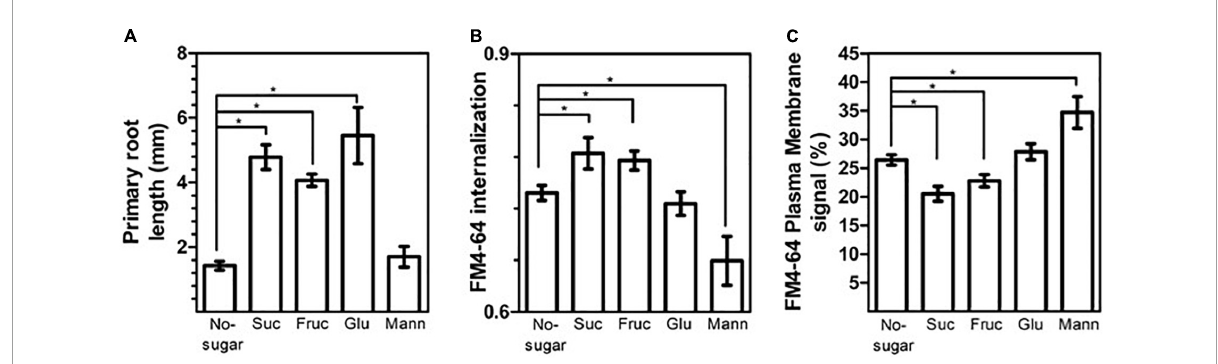
FIGURE7 The sucrose monosaccharide fructose mimics the effect of sucrose on cell elongation and endocytosis. Wild-type Arabidopsis (Col-0) seeds were sown on sugar-free solid medium (No-sugar) and solid medium supplemented with 60 mM sucrose (Suc), fructose (Fruc), glucose (Glu) or mannitol (Mann). (A) Primary root length of seedlings was scored after 7 days from three independent biological replicates of n ≥ 20 seedlings for each condition. (B,C) Endocytosis was evaluated in root epidermal cells from 15 seedlings from each condition in three independent replicates. The plasma membrane, endosome, and whole-cell FM4-64 signal was quantified manually from confocal images after 30 min of FM4-64 internalization. (B) FM4-64 internalization was calculated as the intracellular signal relative to the whole-cell signal. (C) The plasma membrane signal relative to the whole-cell signal is shown as a percentage. (A–C) Error bars represent standard error. (A) Student’s t -test; * p < 0.05. (B,C) Two-tailed Student’s t -test; * p <